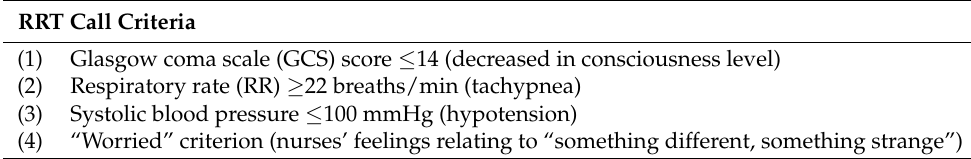
Table 1. RRT call criteria adopted at Nagaoka Red Cross